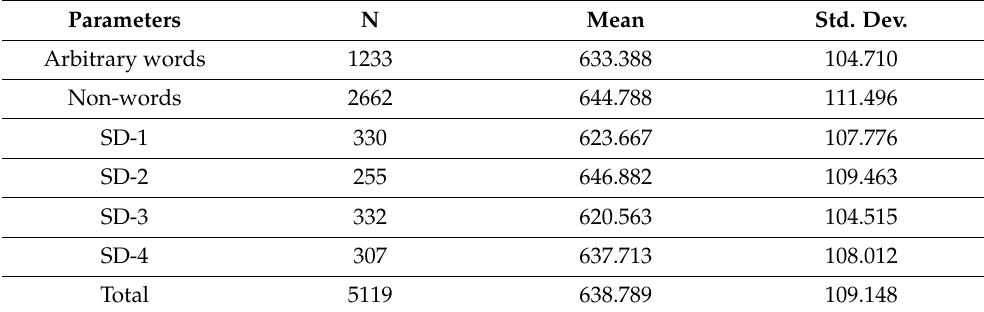
Table 5. Descriptive statistics for the Reaction Time to the English Stimuli Depending on Their Type.